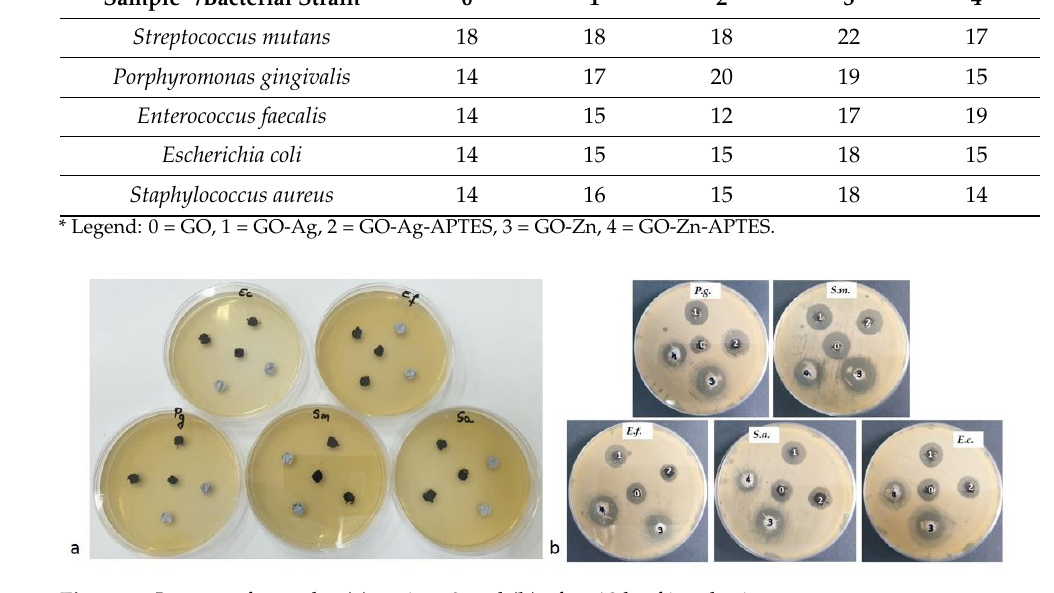
Table 1. The diameter of inhibition zones (mm) for the tested graphenes. Sample */Bacterial Strain